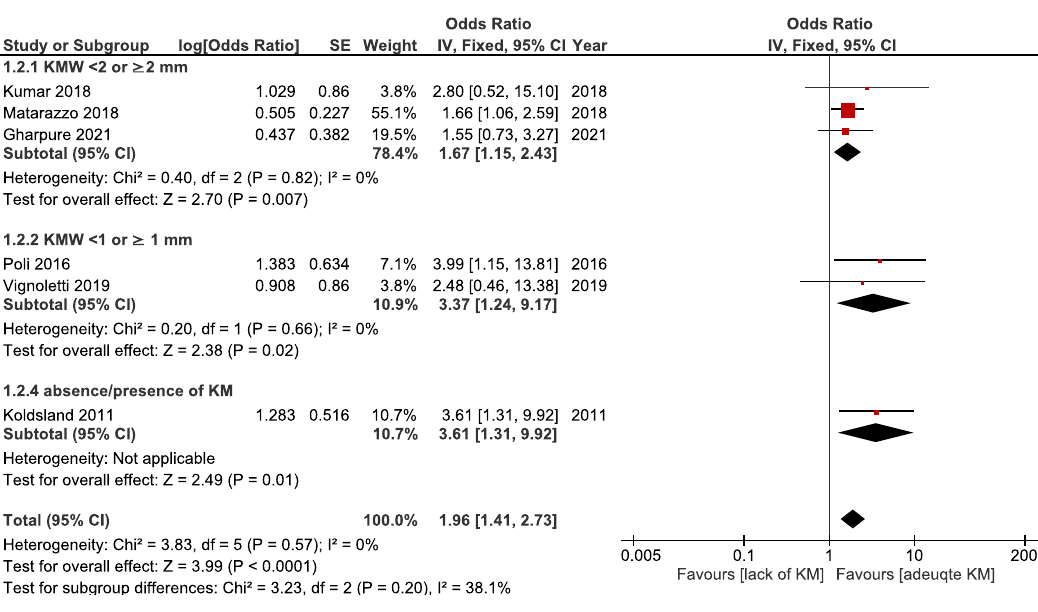
Figure 3. Result of the meta-analysis, including studies with similar case